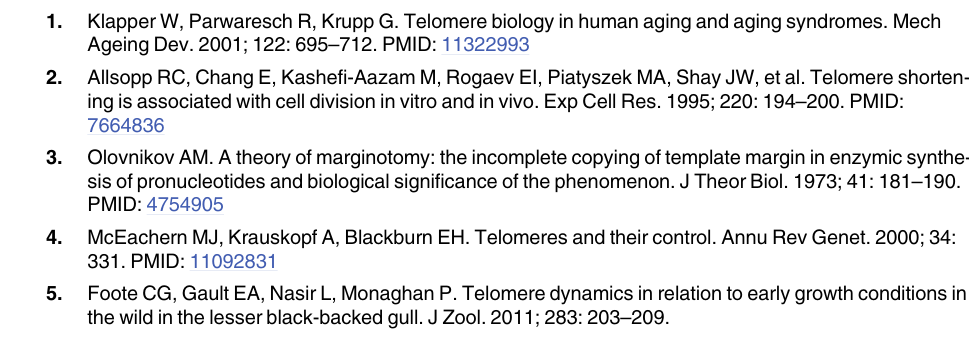
S1 Fig. Confirmation of PCR amplification specificities of Mc1r gene. a. Gel electrophoresis of the PCR products was performed on 1% agarose gel. b. There was a single peak and the melt- ing temperature was 87°C. c. The standard curve constructed by two 5-fold serial dilutions. Each dilution was run by qPCR in duplicate. S2 Fig. Confirmation of PCR amplification specificities of the telomere reaction. a. Gel elec- trophoresis of the PCR products was performed on 1% agarose gel. Two fish species ( G . mor- hua and M . menidia ) where tested and both of them showed a smear consistent with telomeres. b. The standard curve constructed by a 10-fold serial dilution using M . menidia sample. Each dilution was run by qPCR in